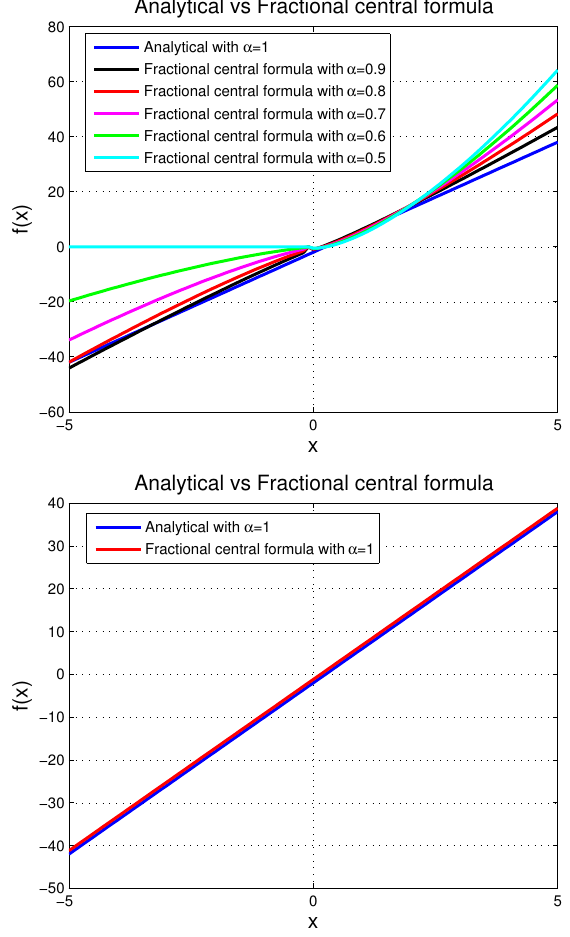
Figure 1. Comparison results between the analytical and fractional central formulas for Example 1.